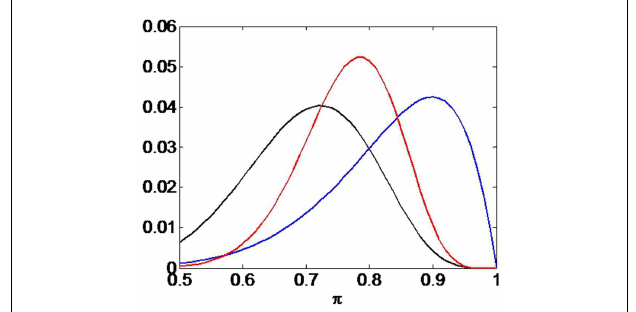
FIGURE 8 | Confirmation bias .The black curve shows the prior p ( π ), the blue curve the likelihood p ( b | π ), and the red curve the posterior p ( π | b ).The curves have been scaled (on the y -axis) for ease of comparison. If the prior places more probability mass on smaller values of π than does the likelihood (e.g., through “stupid” priming) then the posterior will take on lower values than the maximum likelihood value.